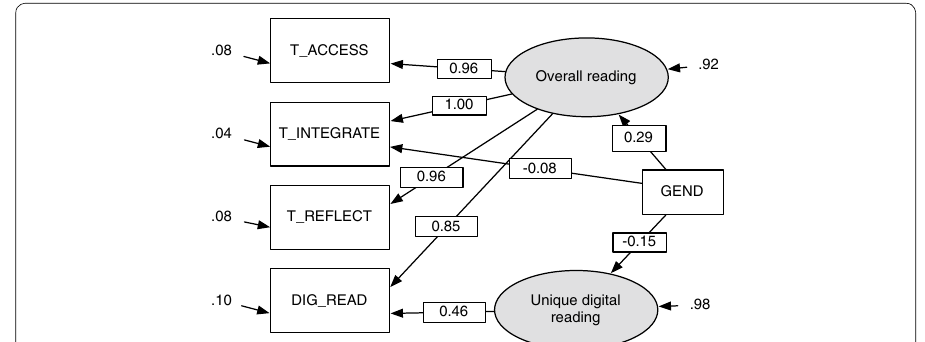
Fig. 1 The baseline model previously tested on the Swedish data (Rasmusson and Åberg-Bengtsson